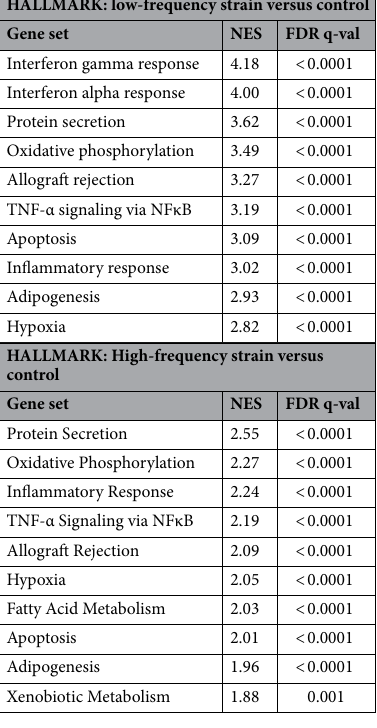
REACTOME: exclusive to high-frequency strain